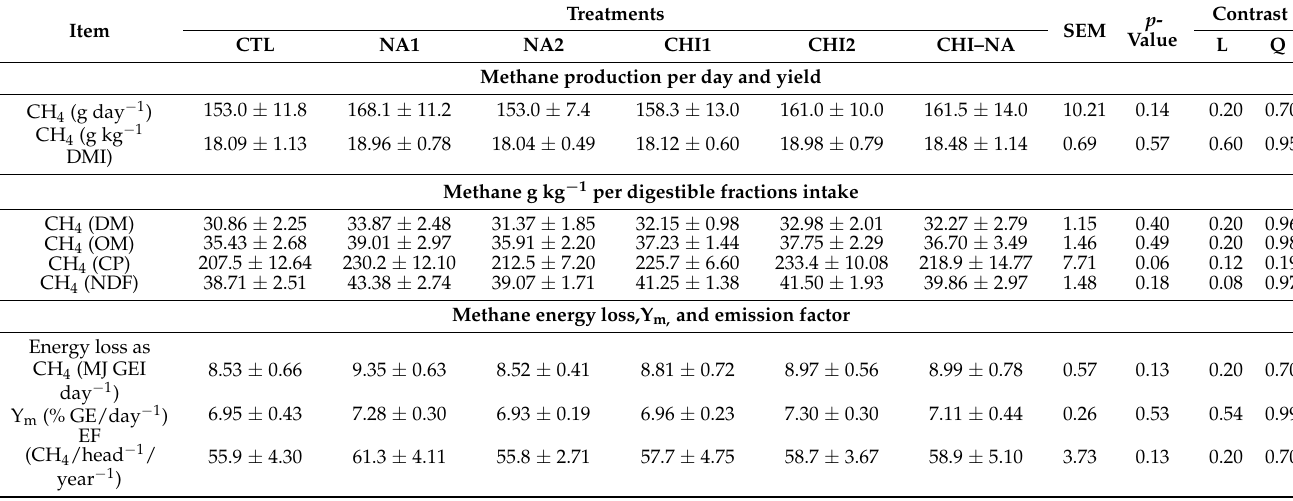
Table 7. Effect of NA and CHI supplementation on enteric CH 4 production in